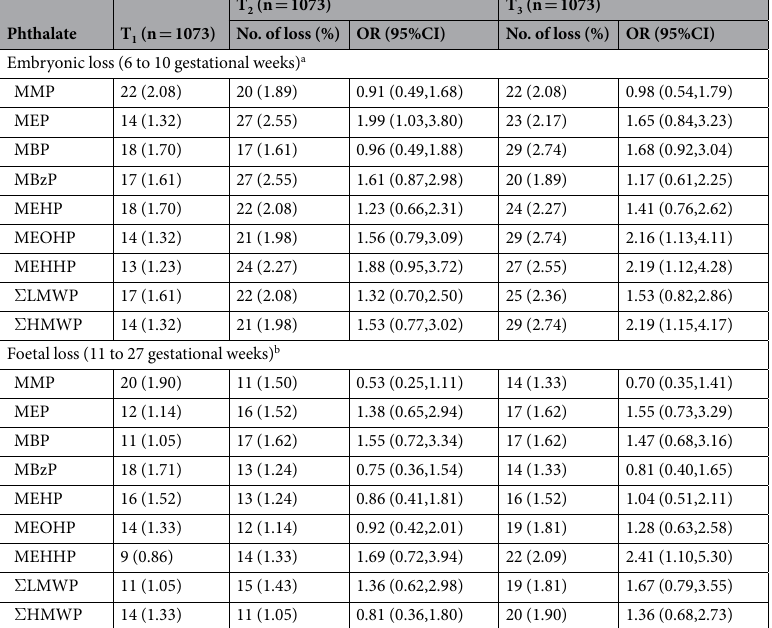
Table 3. Logistic regression analyses of associations of phthalate metabolites with embryonic and foetal loss. Abbreviations: OR, odds ratio; CI, confidence interval; T 1/2/3 , the first/second/third tertile of phthalate concentrations. a Adjusted for education and gestational weeks of urine collection. b Adjusted for age, prepregnancy BMI, education, parity and gestational weeks of urine